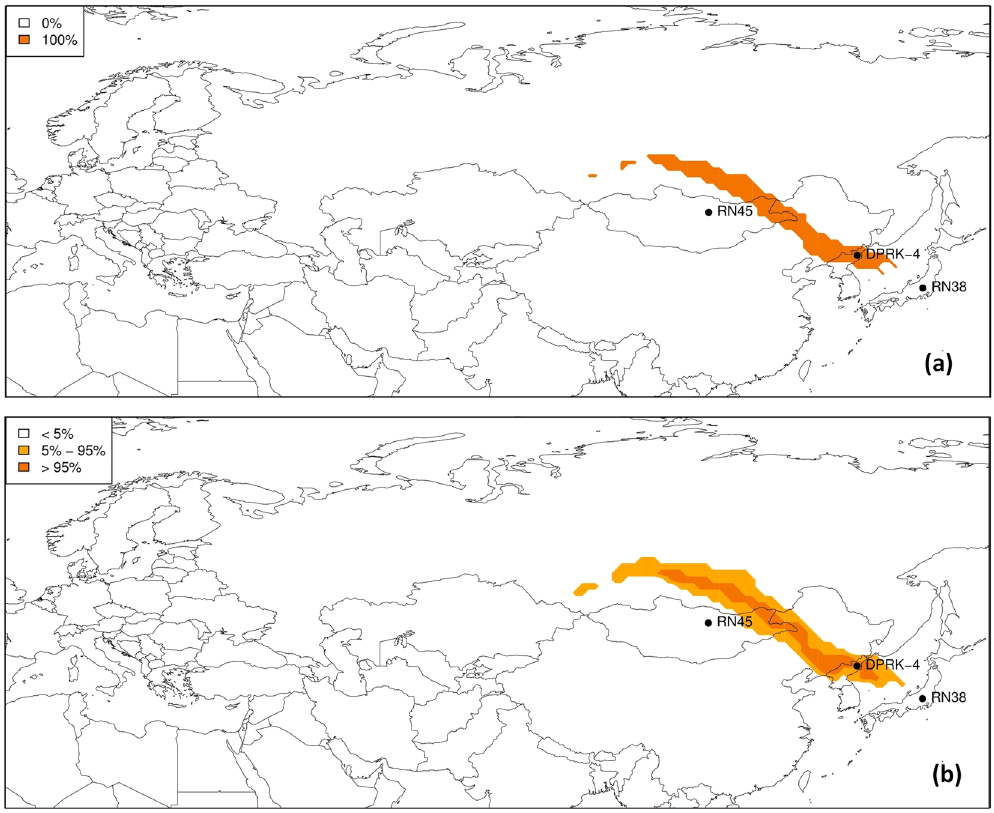
Figure 3. Pointwise probability that a certain grid point is a possible source for ( a ) the unperturbed simulation (thus fully deterministic) and ( b ) the full 51 member ensemble. Maps have been generated using ref.